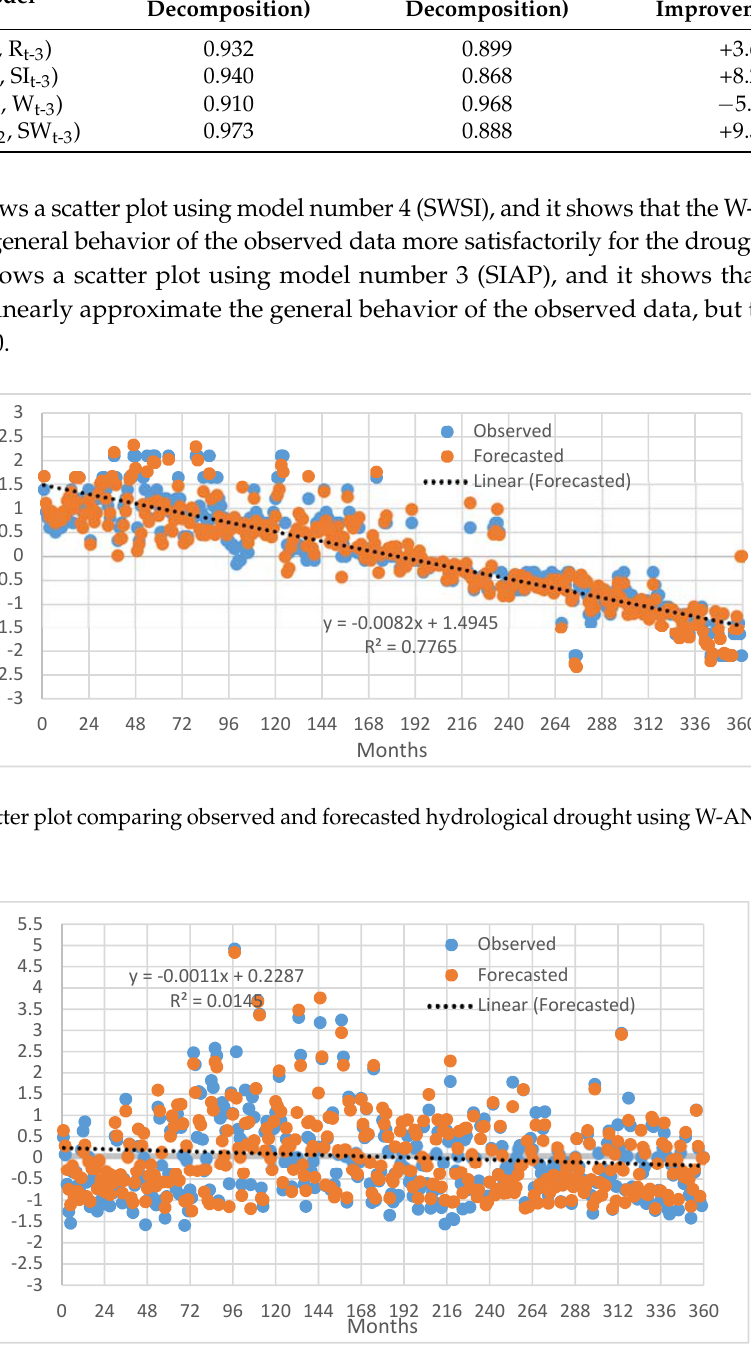
Table 10. Performance improvement of R statistics of different W-ANN models.